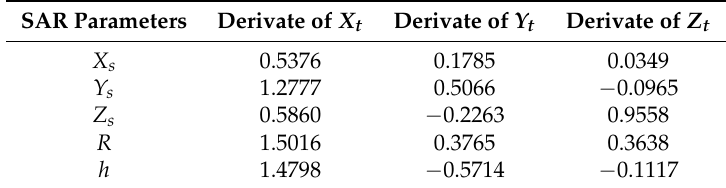
Table 2. The derivates of geolocation with respect to SAR parameters on 20100623 and 20100808.